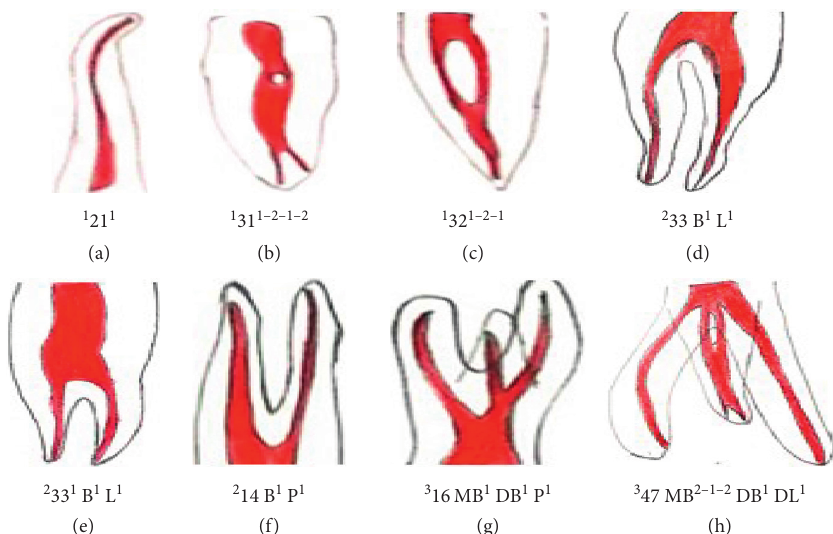
Figure 4: Classification of root and root canal morphology in permanent dentition by Ahmed et